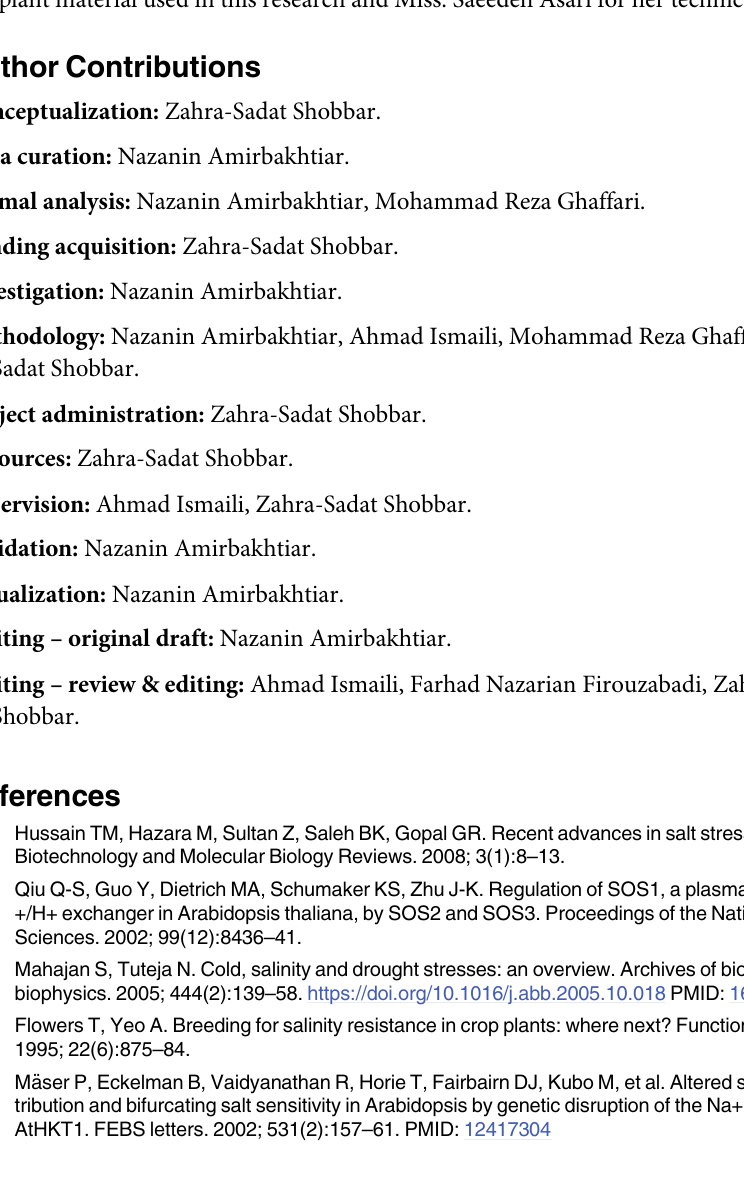
S12 Table. KEGG pathway classification of DEGs. S13 Table. List of differentially expressed genes having alternative splicing events. S14 Table. The results of mapping the DEGs to the metabolic pathway overview. S15 Table. List of some salt responsive genes located in the proposed